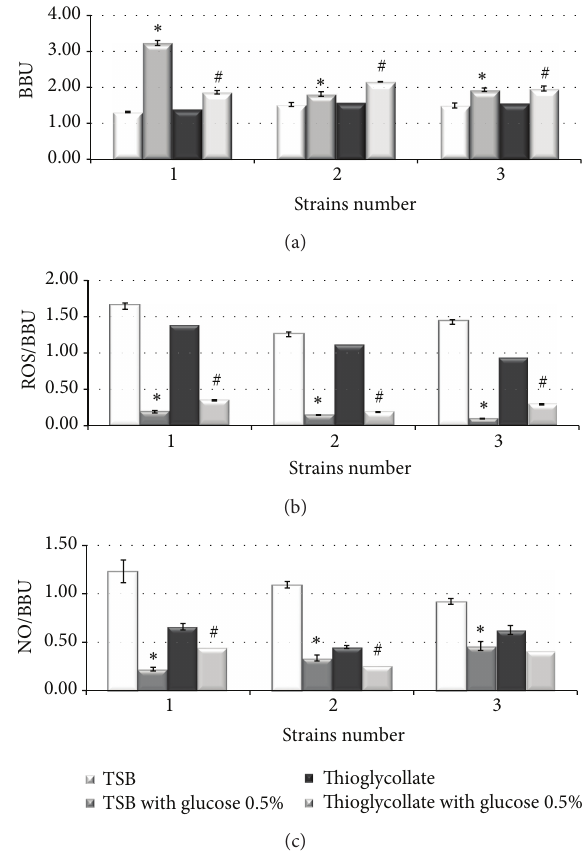
Figure 1: Quantification of biofilm formation of STEC strains by crystal violet (CV) staining expressed in biofilm biomass units (BBU): (a) in TSB; with addition of 0.5% glucose; in thioglycollate medium alone and with the addition of 0.5% glucose. (b) ROS ratio (ROS/BBU) determined by NBT assay. (c) NO and BBU ratio (NO/BBU) determined by Griess method. Error bars represent the standard deviations of the means of three independent experiments. # 𝑃 versus TSB < 0.01 and # 𝑃 versus thioglycollate medium < 0.01 being considered statistically